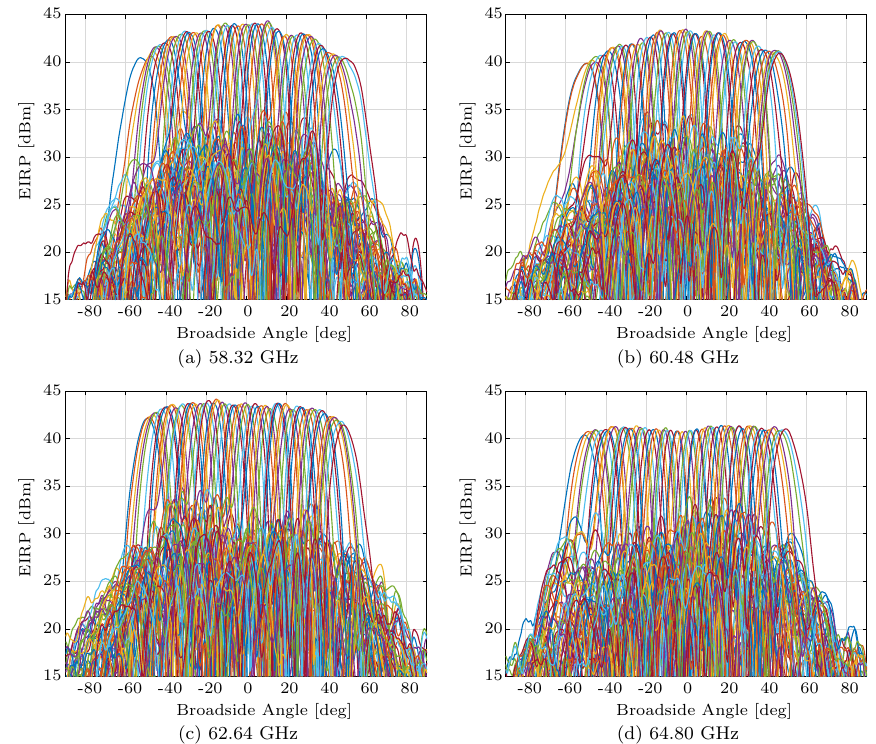
Fig. 14 Radiation pattern of the four WiGig channels covered by the antenna module. The phase shifters are set to maximum gain and the signal chain is saturated